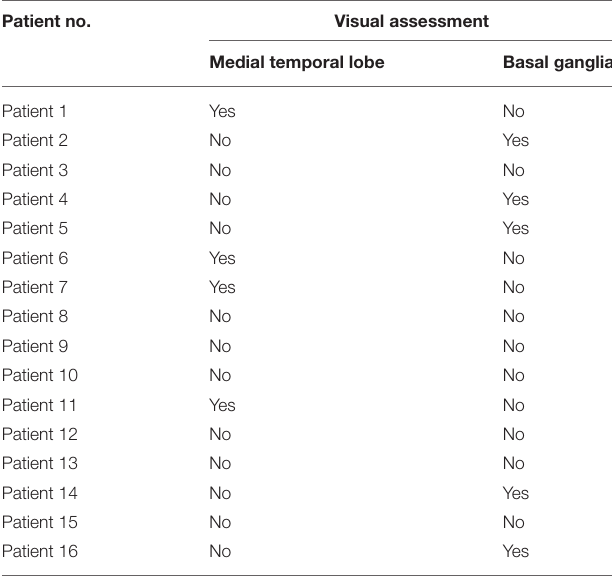
TABLE 3 | The patients with anti-LGI1 encephalitis who were non-completely detectable by visual assessment (non-CD patients). Patient